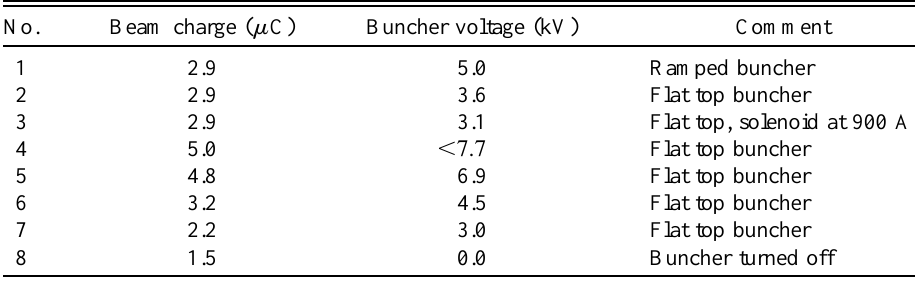
TABLE I. Buncher voltages needed for the marginally stable beam. Note that 4.8 m C corresponds to 3.0 3 10 13 protons.